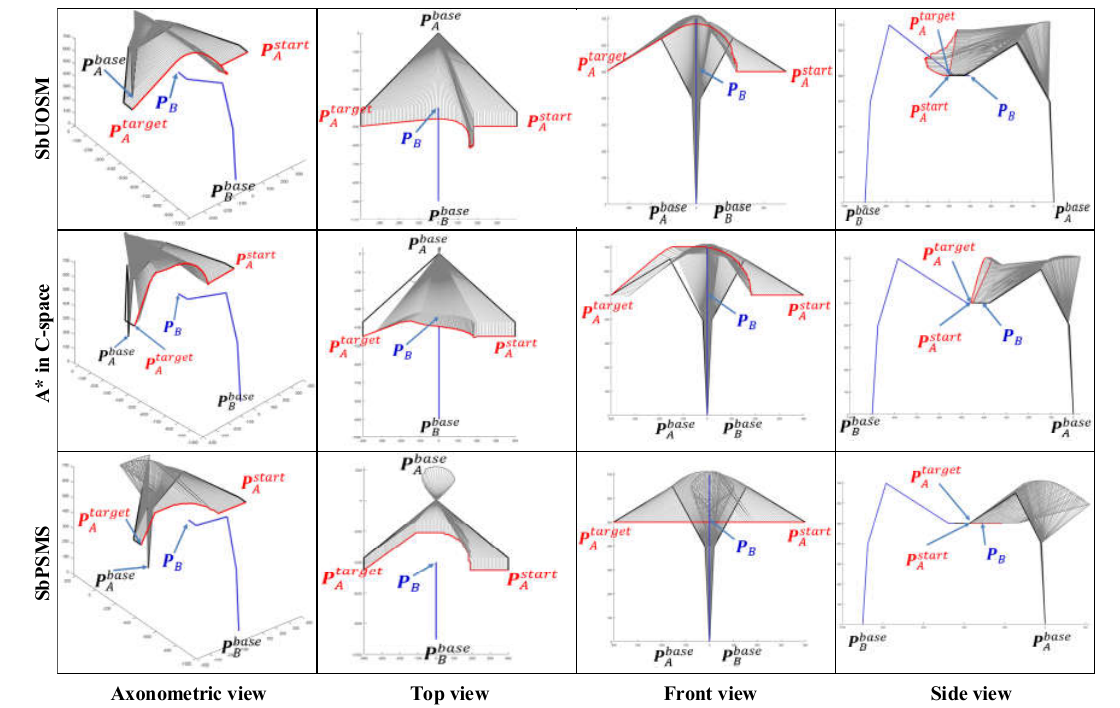
Figure 12. Comparison of simulation results of three path-planning algorithms for Case 6. Table 1. Summary table of planning path deviations for the three algorithms under all six cases (Unit: mm).